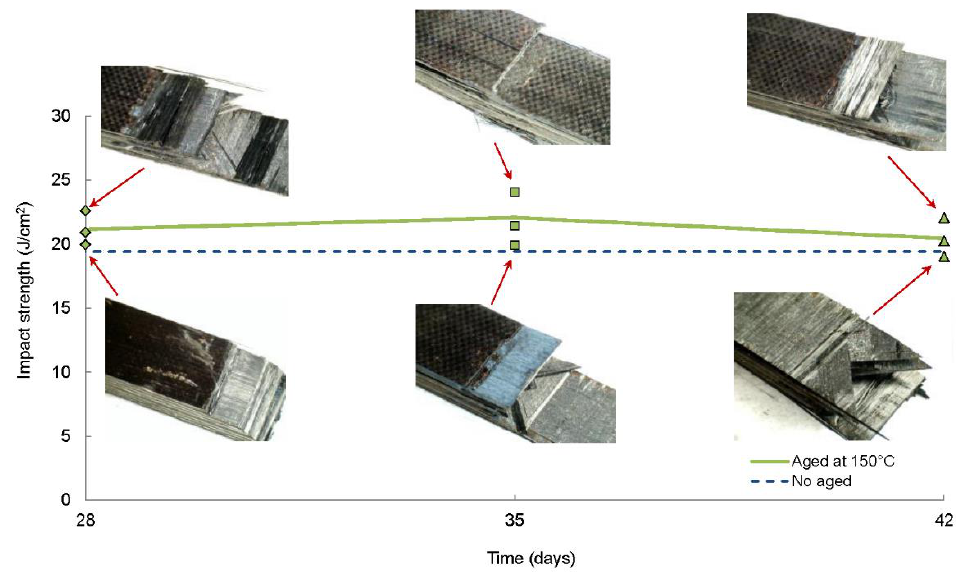
Figure 7. Average impact strength (E c ) and failure modes of quasi-isotropic [0/90/±45] 2s laminates aged at 150 °C for different periods: 28, 35 and 42 days ( E impact = 32.46 J).